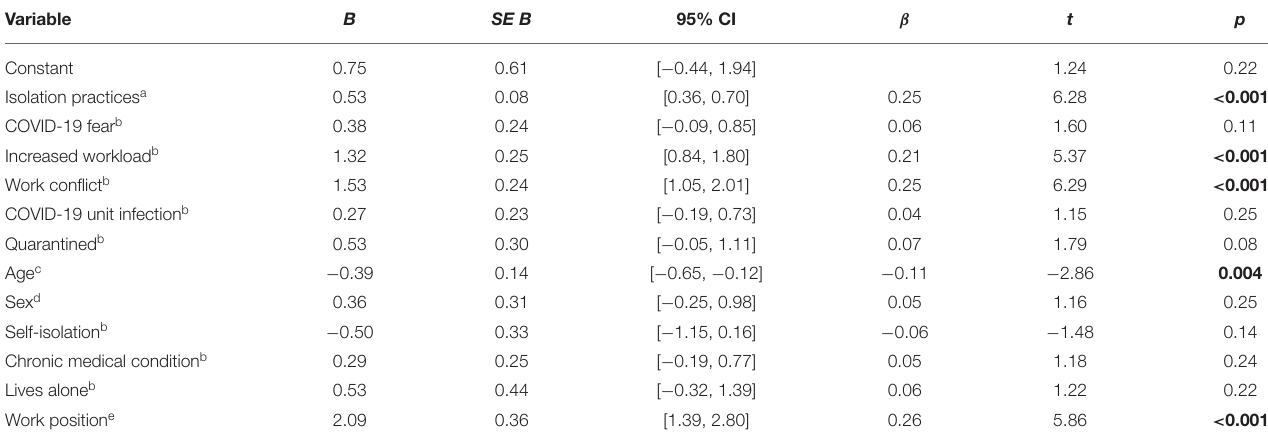
TABLE 6 | Multiple linear regression analysis for worker variables predicting MBI-2 burnout score. Variable B SE B 95% CI Constant